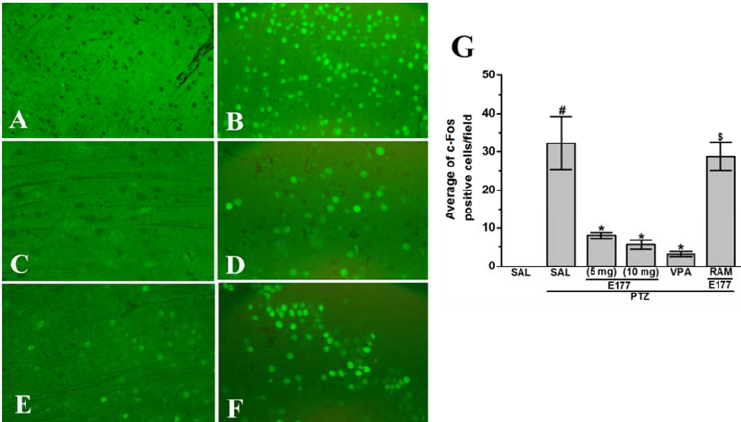
Figure 7. H3R antagonist E177 treatment mitigated altered levels of c-Fos protein expression in hippocampus of PTZ-kindled rats. Profound expression of c-Fos protein in the hippocampus of PTZ-kindled rats ( B ) when compared to saline-treated control rats ( A ). Quantitative analysis ( G ) of c-Fos positive cells revealed that reference drug VPA (300 mg / kg, ( C )) and H3R antagonist E177 (5 and 10 mg / kg, ( D , E )) significantly mitigated the increased levels of c-Fos in PTZ-kindled rats. Chronic systemic co-injection of RAM (10 mg / kg, i.p) counteracted the E177 (5 mg)-provided amelioration of c-Fos-expression of PTZ-kindled rats ( F ). # P < 0.05 for average c-Fos positive cells compared with saline-treated control group. * P < 0.05 for average c-Fos positive cells compared with PTZ-kindled rats. $ P < 0.05 for average c-Fos positive cells vs. H3R antagonist E177 (5 mg)-treated PTZ-kindled rats. Data are expressed as mean ± SEM ( n =